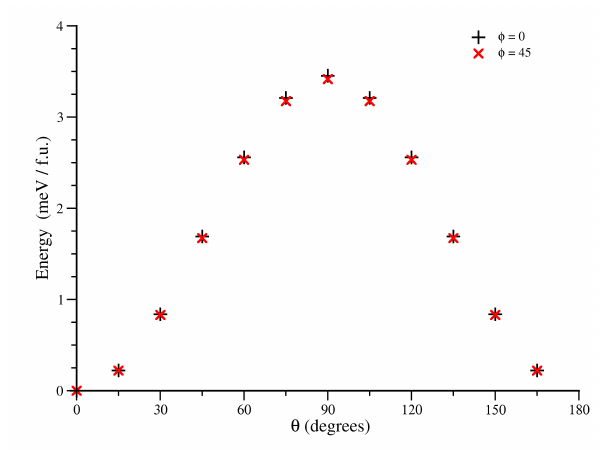
Figure 6. Variation of total energy (in meV / f.u.) with angle from the easy axis, θ , for two values of the azimuthal angle, φ = 0 and φ = 45 ◦ for FePt. θ is expected to be the dominant term under the uniaxial